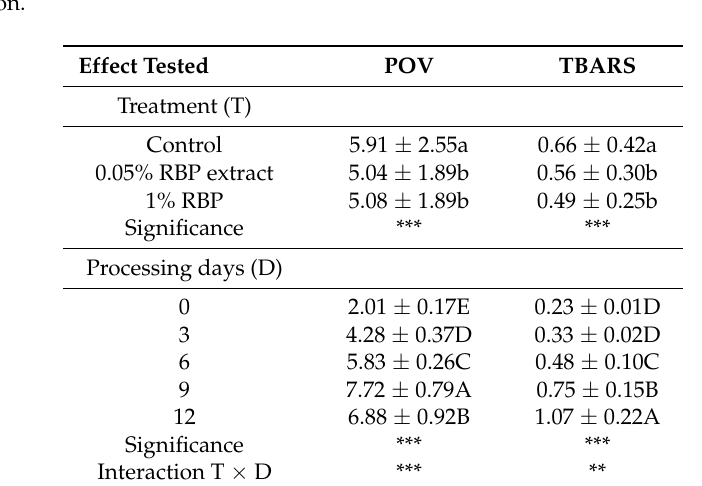
Table 4. Two way ANOVA for different treatments, processing days, and their interaction on lipid